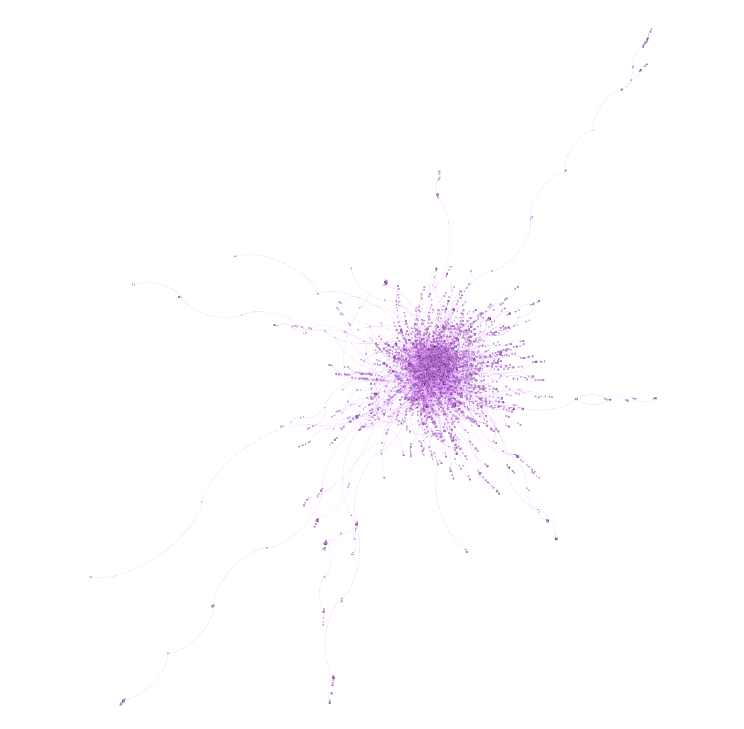
Figure 5. SC1 is the largest sub-community and is a more general and distributed